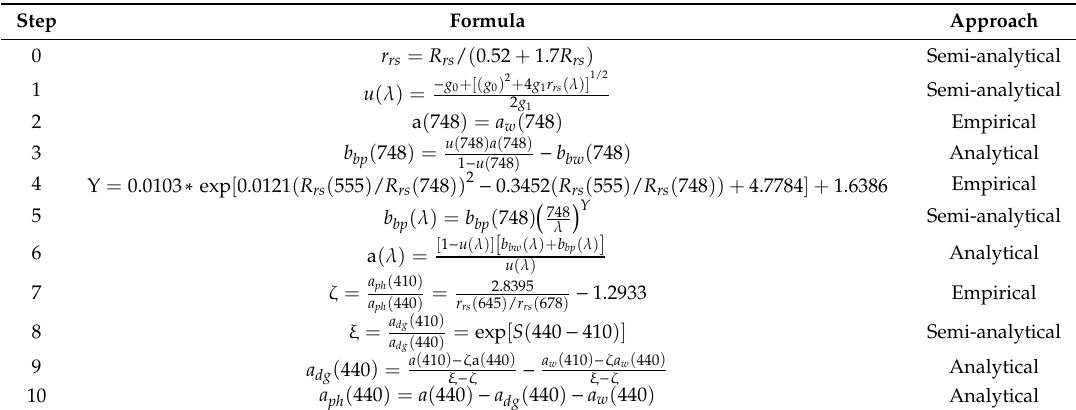
Table 4. Steps of the improved quasi-analytical algorithm (QAA).